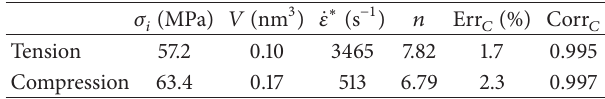
comparable to what was observed by El-Qoubaa and Othman [40] where 𝑉 1 ≈ 1.7𝑉 2 for PEEK.